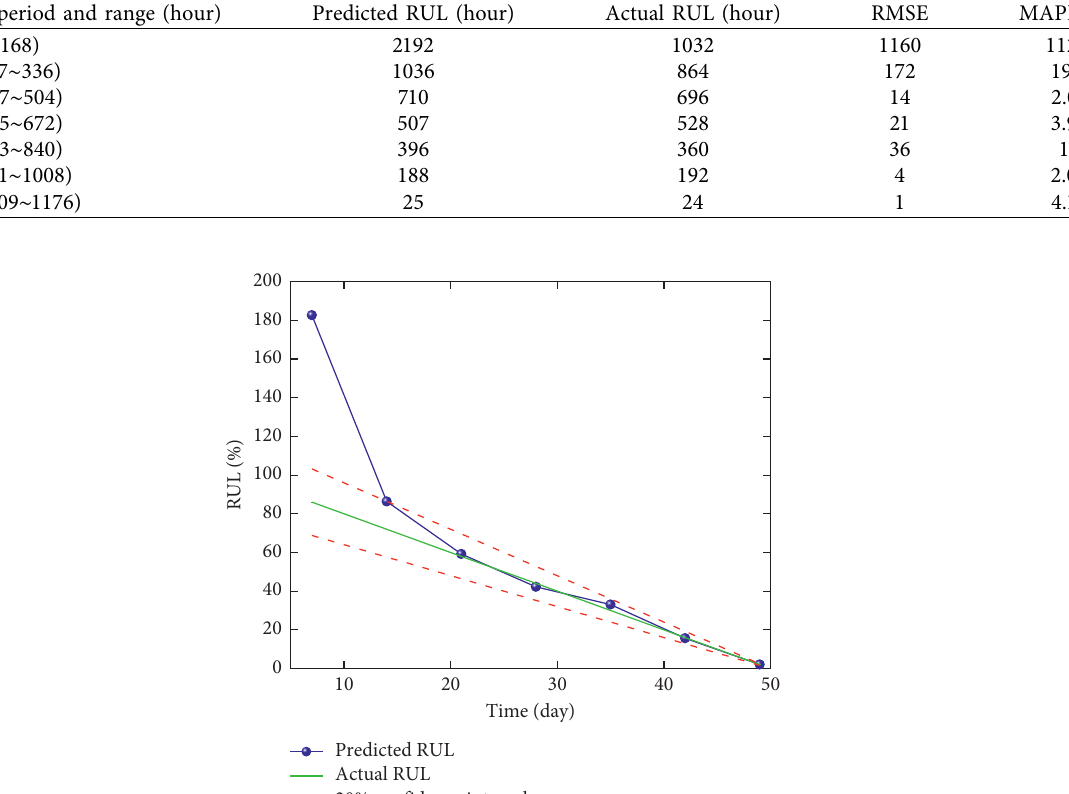
Figure 13: Comparisons of the RUL results for bearings under different monitoring periods. Table 6: Comparisons among real and predicted RUL values.